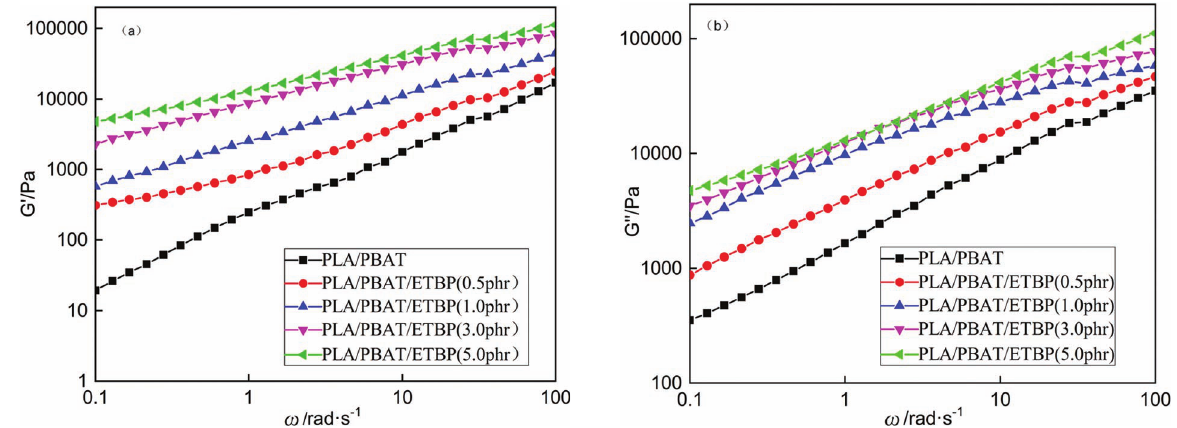
Figure 12: G’-ω relation curves (a) and G’’-ω relation curves (b) of the PLA/PBAT/ETBP blends.